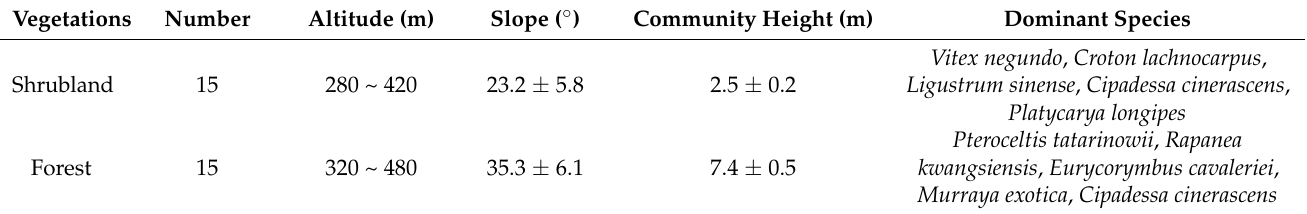
Table 1. Plot characteristics of the two vegetations in a karst ecosystem in southwest